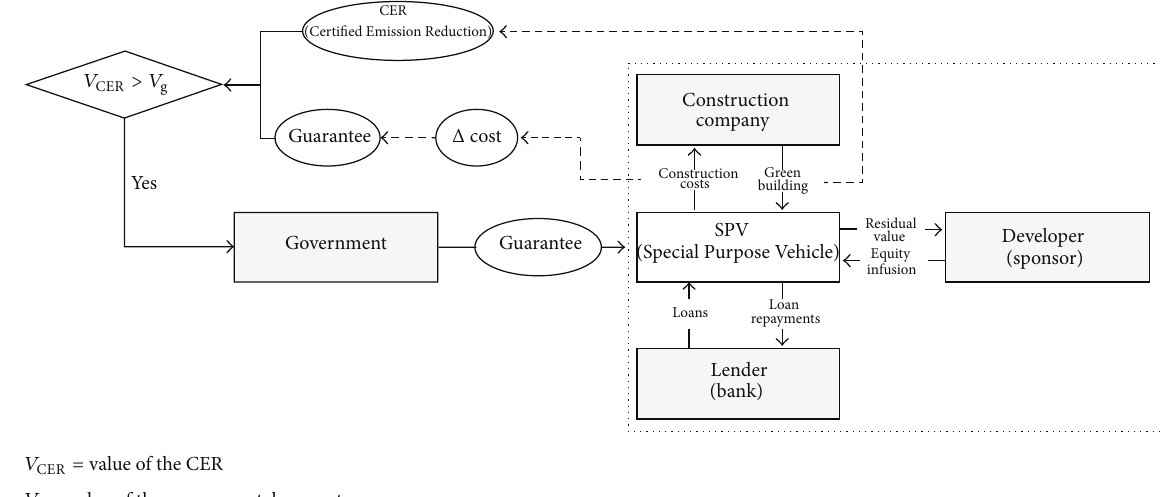
Figure 2: Proposed financing model for facilitating Green